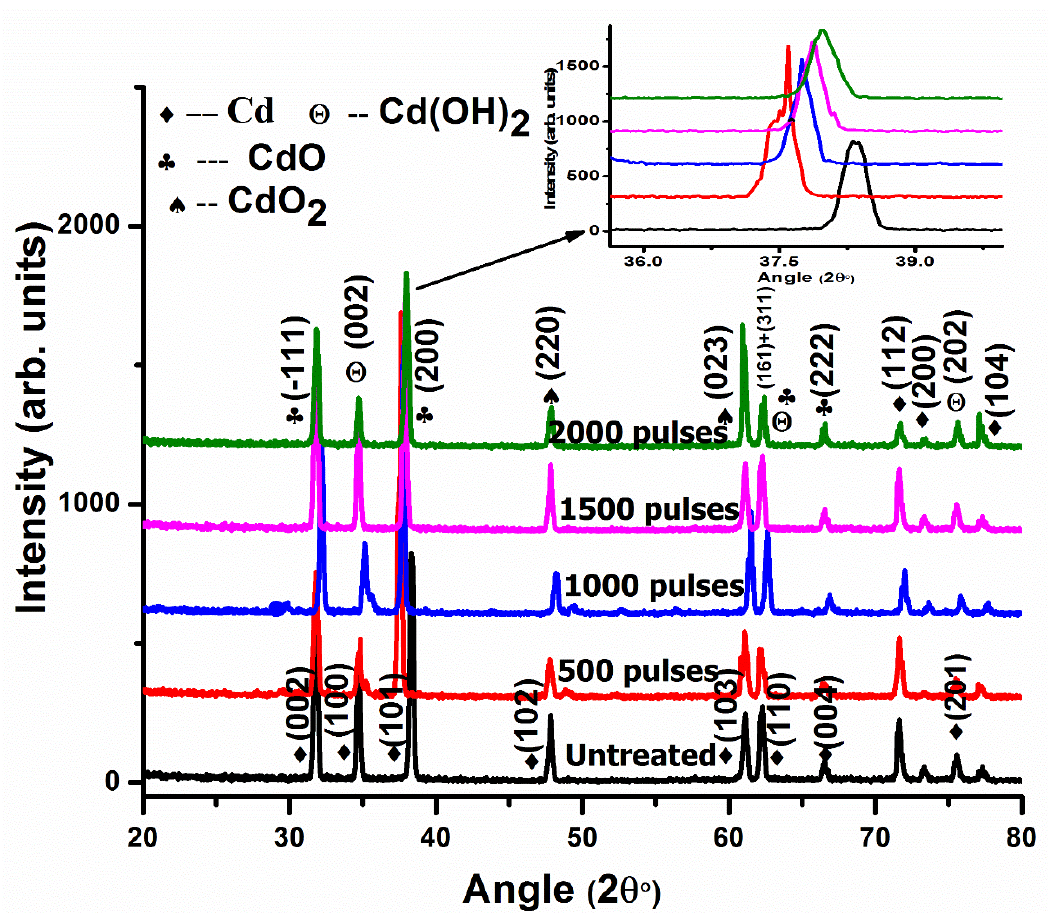
Figure 5. XRD patterns of pristine and laser ablated Cd exposed to 500, 1000, 1500, and 2000 laser pulses at a constant fluence value of 3.6 Jcm − 2 in DI water, enlarged view of peak (200) shown as inset at top right corner.